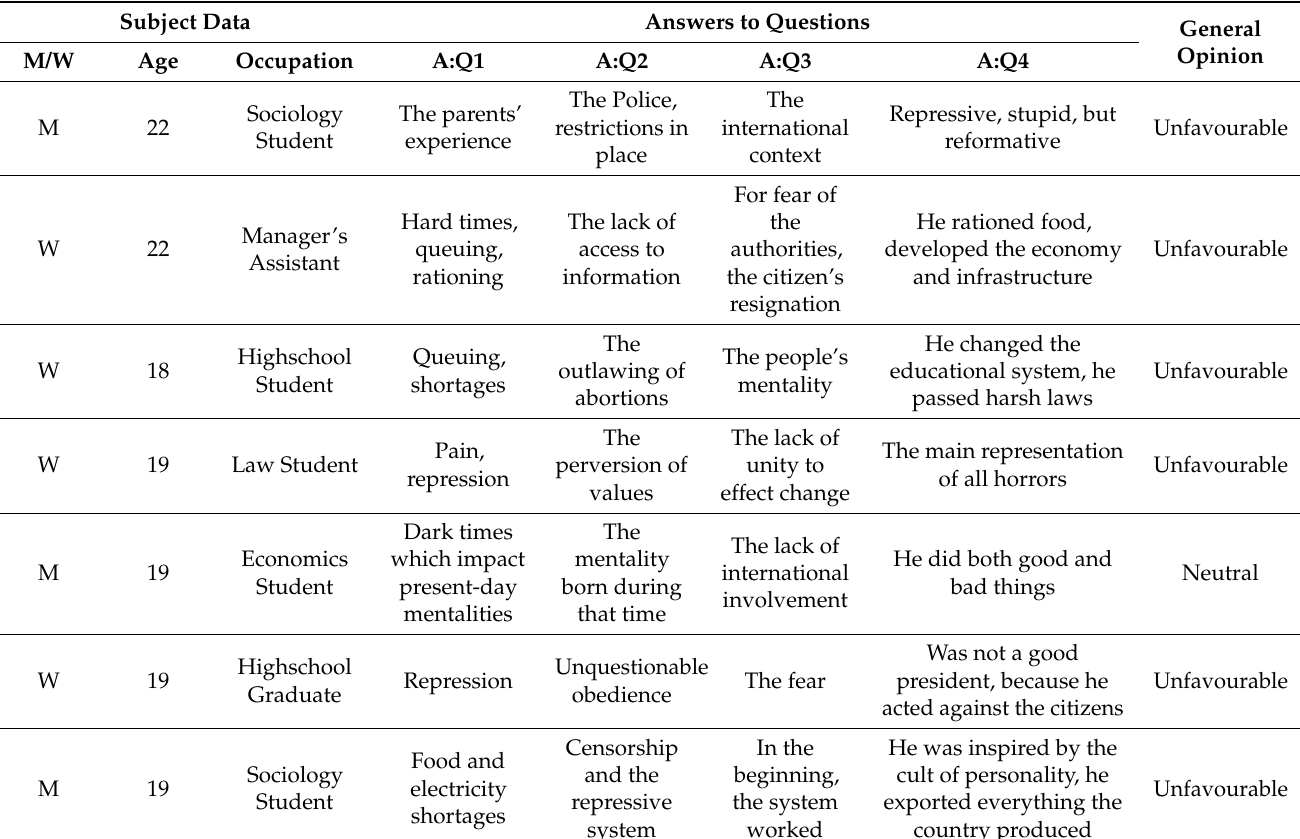
Table 2. The young people’s perception of communism [58]. Questions asked: 1. What is the first thing you think of when you hear the word “communism”? 2. What do you think was the main issue Romanians were confronted with during the communist era? 3. Why do you think Romania lived under communism for over 40 years? 4. What do you know of Nicolae